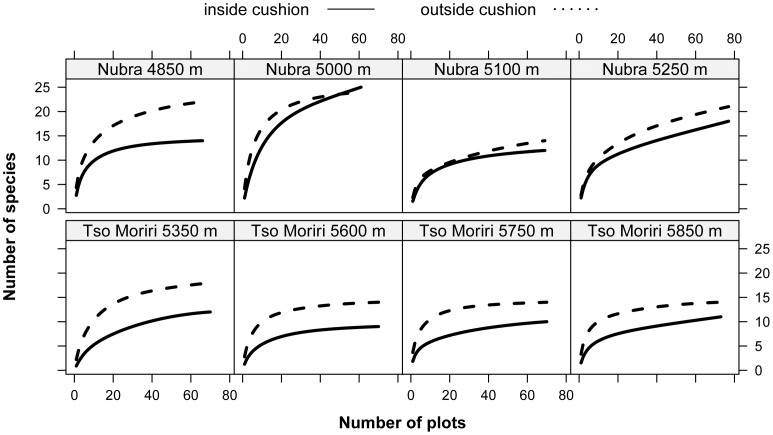
Sample-based rarefaction curves for cushions and open areas on each study site.Note an increase in the number of species encountered with increasing number of plots sampled. Open areas outside cushions are more species rich than equal areas inside cushions at all elevations.